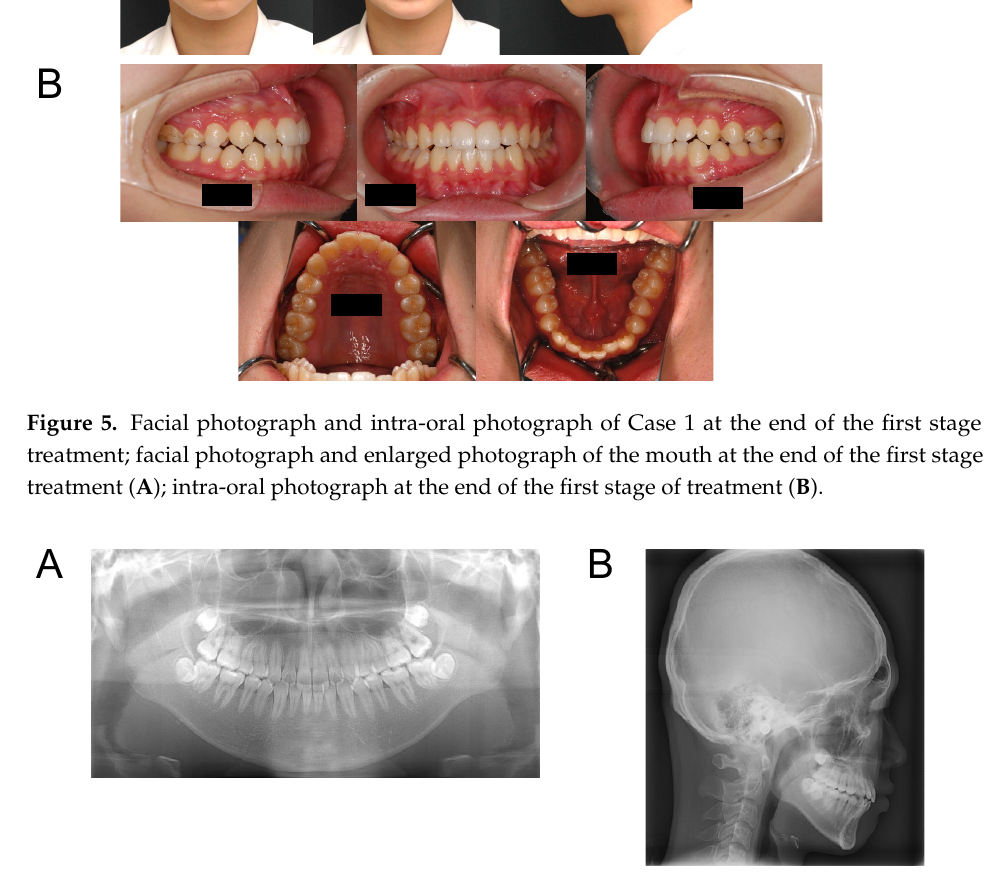
Figure 6. Panoramic radiograph ( A ) and lateral roentgenographic cephalogram ( B ) of Case 1 at the end of the first stage of